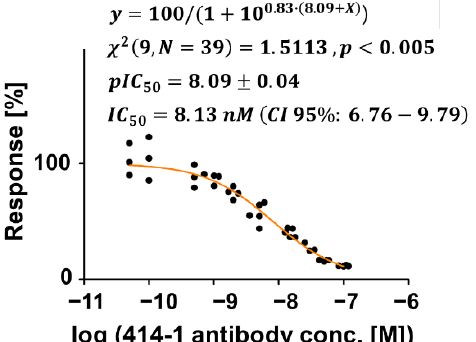
Figure 4. Assessing an anti-S1 antibody (414-1) as an inhibitor of the S1-ACE2 interaction. Binding curve of the S1-ACE2 interaction with increasing concentrations of the anti-S1 antibody. Measure- ments were normalized to the average signal (designated as 100% Response) when S1 binds with ACE2, at 0 nM of the anti-S1 antibody. The orange line was fitted using a non-linear regression analysis to the log (inhibitor) versus the normalized response using GraphPad. The chi-square Goodness of fit is reported as 𝜒 2 (degrees of freedom, sample size). IC 50 and pIC 50 , and their SEM were extracted from the fitted line and are reported as pIC 50 ± SEM and IC 50 (CI 95%: lower limit – upper limit). For each concentration 3 ≤ 𝑛 ≤ 5 .